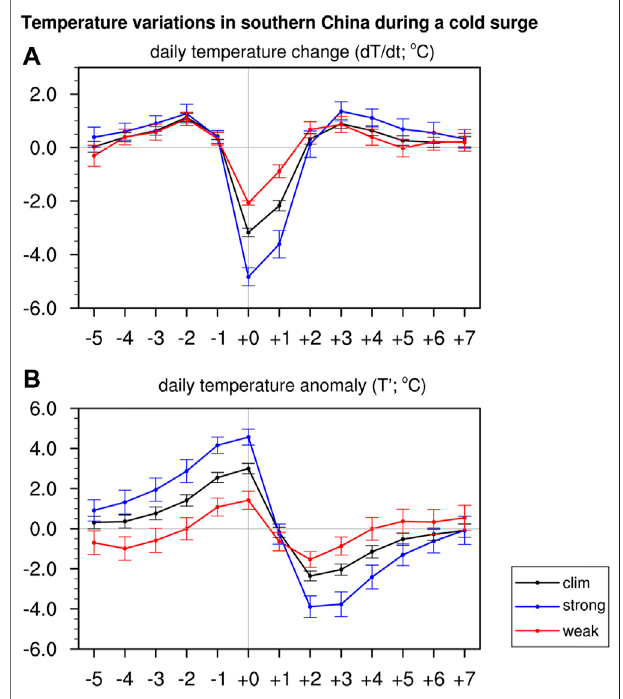
FIGURE1| TemperaturevariationsinsouthernChina(22.5 ° – 25.0 ° Nand 112.5 ° – 117.5 ° E) from day-5 to day +7 of a cold surge: (A) daily temperature change (difference between day n + 1 and day n ), (B) daily temperature anomaly. Unit: ° C. In each plot, black, blue and red color represents the climatological, strong and weak cold surge, respectively. Solid lines indicate the values averaged across the surges belonging to the same category, and error bars denote the 95%con fi dence interval derived from thestandard error across the surges belonging to the same